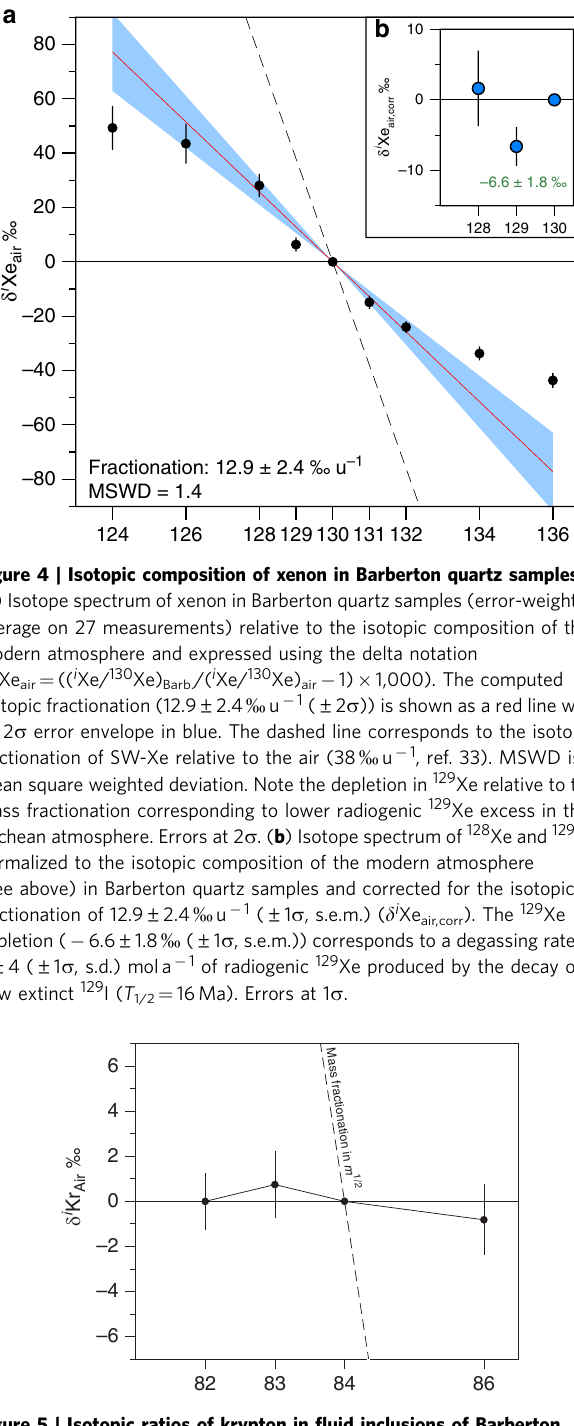
is estimated at 527 ± 102 mol a (cid:2) 1 (ref. 36). Estimates for the mantle 130 Xe/ 3 He ratio range from 0.85 (cid:3) 10 (cid:2) 3 to 3.5 (cid:3) 10 (cid:2) 3 (refs 37–39) and values between 1.29 and 1.7 for the 129 Xe(I)/ 130 Xe (ref. 40), this leads to a modern degassing rate of NATURE COMMUNICATIONS|8:15455|DOI: